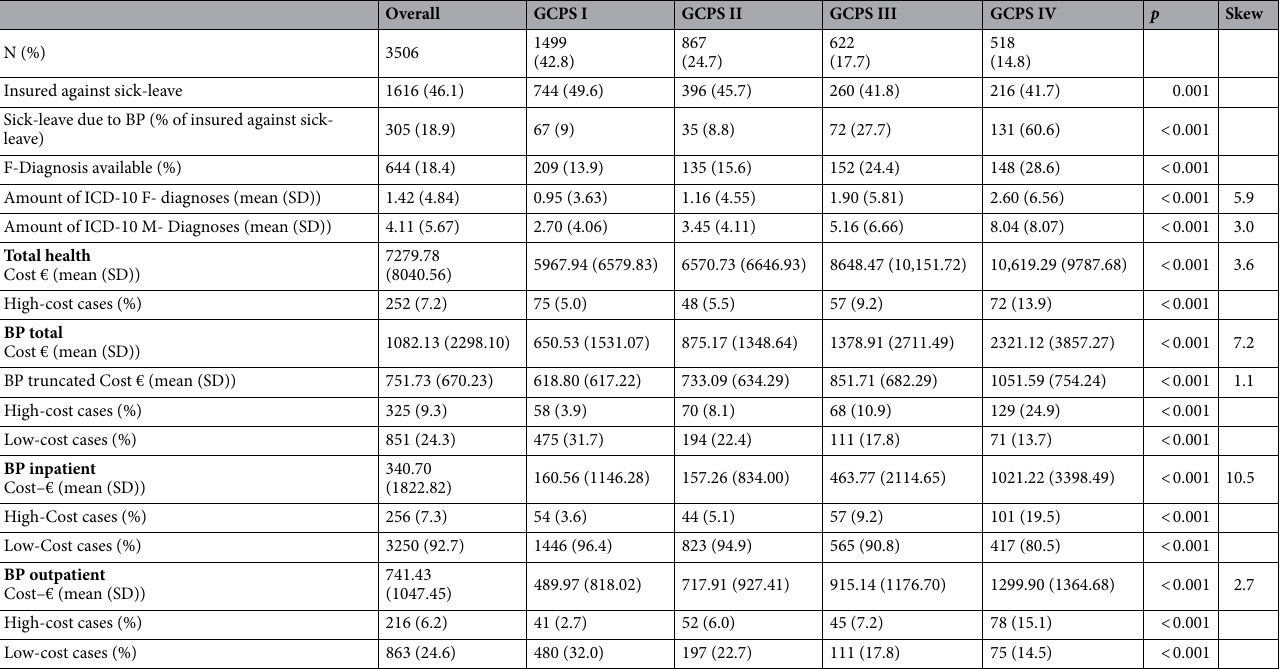
Table 5. Healthcare use and costs during the 12 months before enrolment according to GCPS. Definition of GCPS: Grade I Low disability-low intensity, Grade II Low disability-high intensity, Grade III High disability- moderately limiting, Grade IV High disability-severely limiting. High-cost cases were calculated using the Tukey method with 1.5 * IQR 69 . Truncated mean Exclusion of high-cost cases and cases who did not submit a BP invoice in the last 12 months prior to